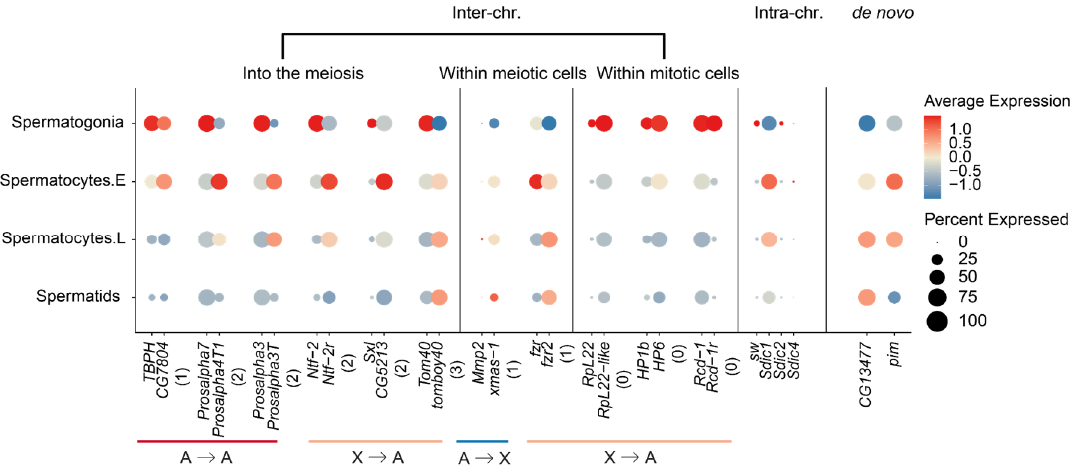
Figure 4. New gene cases of ‘into the meiosis’. We show each pair of parental (left) and new (right) genes next to each other for their color-scaled expression levels and percentage of expressed cells scaled by the bubble size within each type of testis cell. Genes are selected based on their previous functional studies. The number below each gene pair was the extent and direction of testis cell type changes between the parental and new genes, which was defined in Figure 3b.